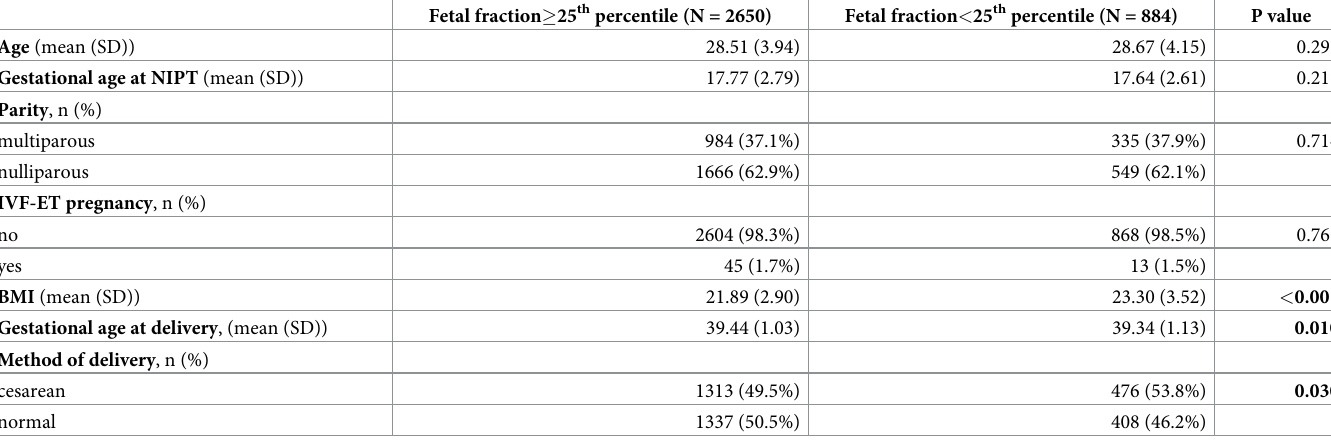
Table 1. Characteristics of pregnant women with low fetal fraction compared with women with normal fetal fraction.